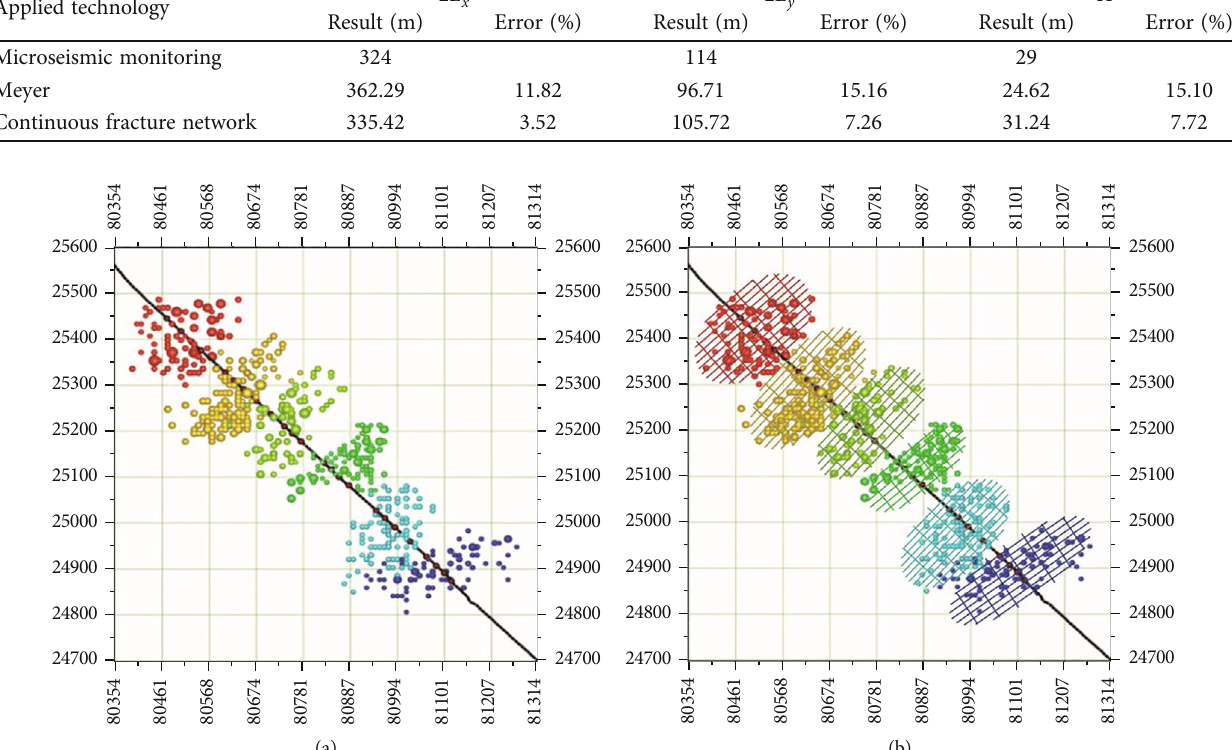
Figure 13: (a) Results of microseismic monitoring of TP12-06. (b) Comparison of prediction results of microseismic monitoring and continuous fracture network model. Table 5: Comparison of prediction results of well TP12-06 by di ff erent technologies.